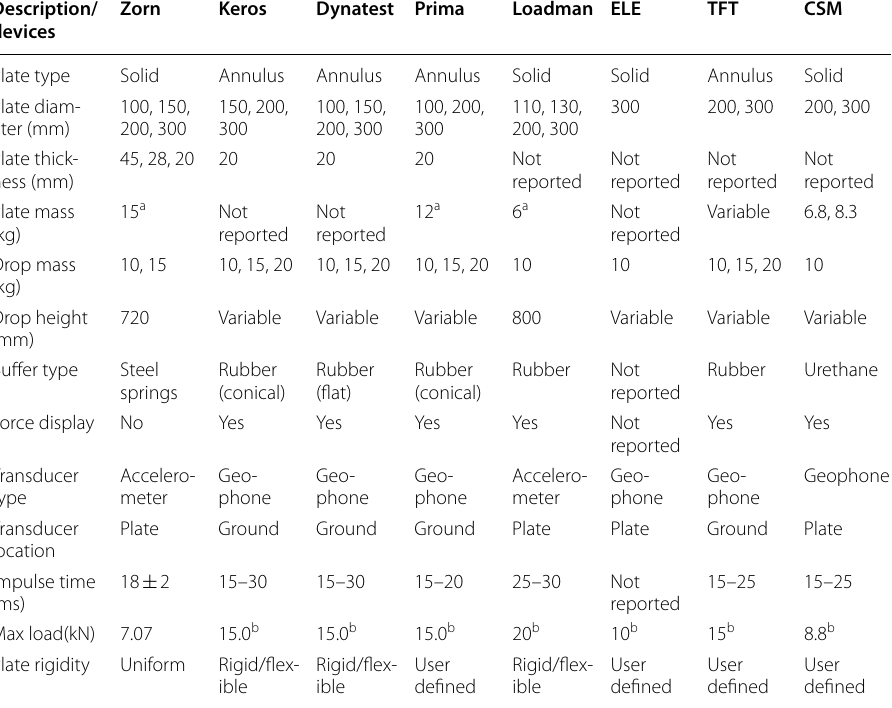
Table 3 Summary of specifications of the LWD devices. (Modified after